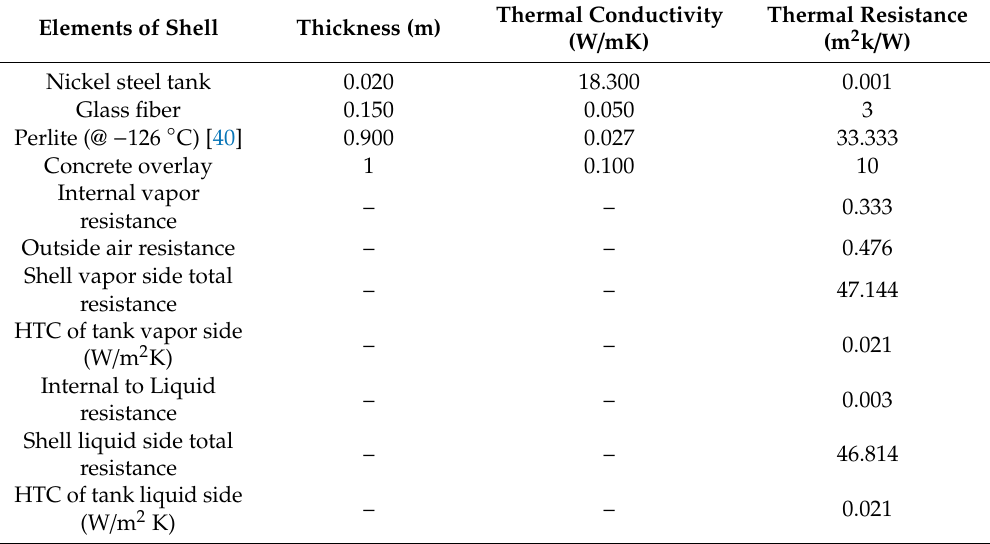
Table 2. Elements of LNG tank shell